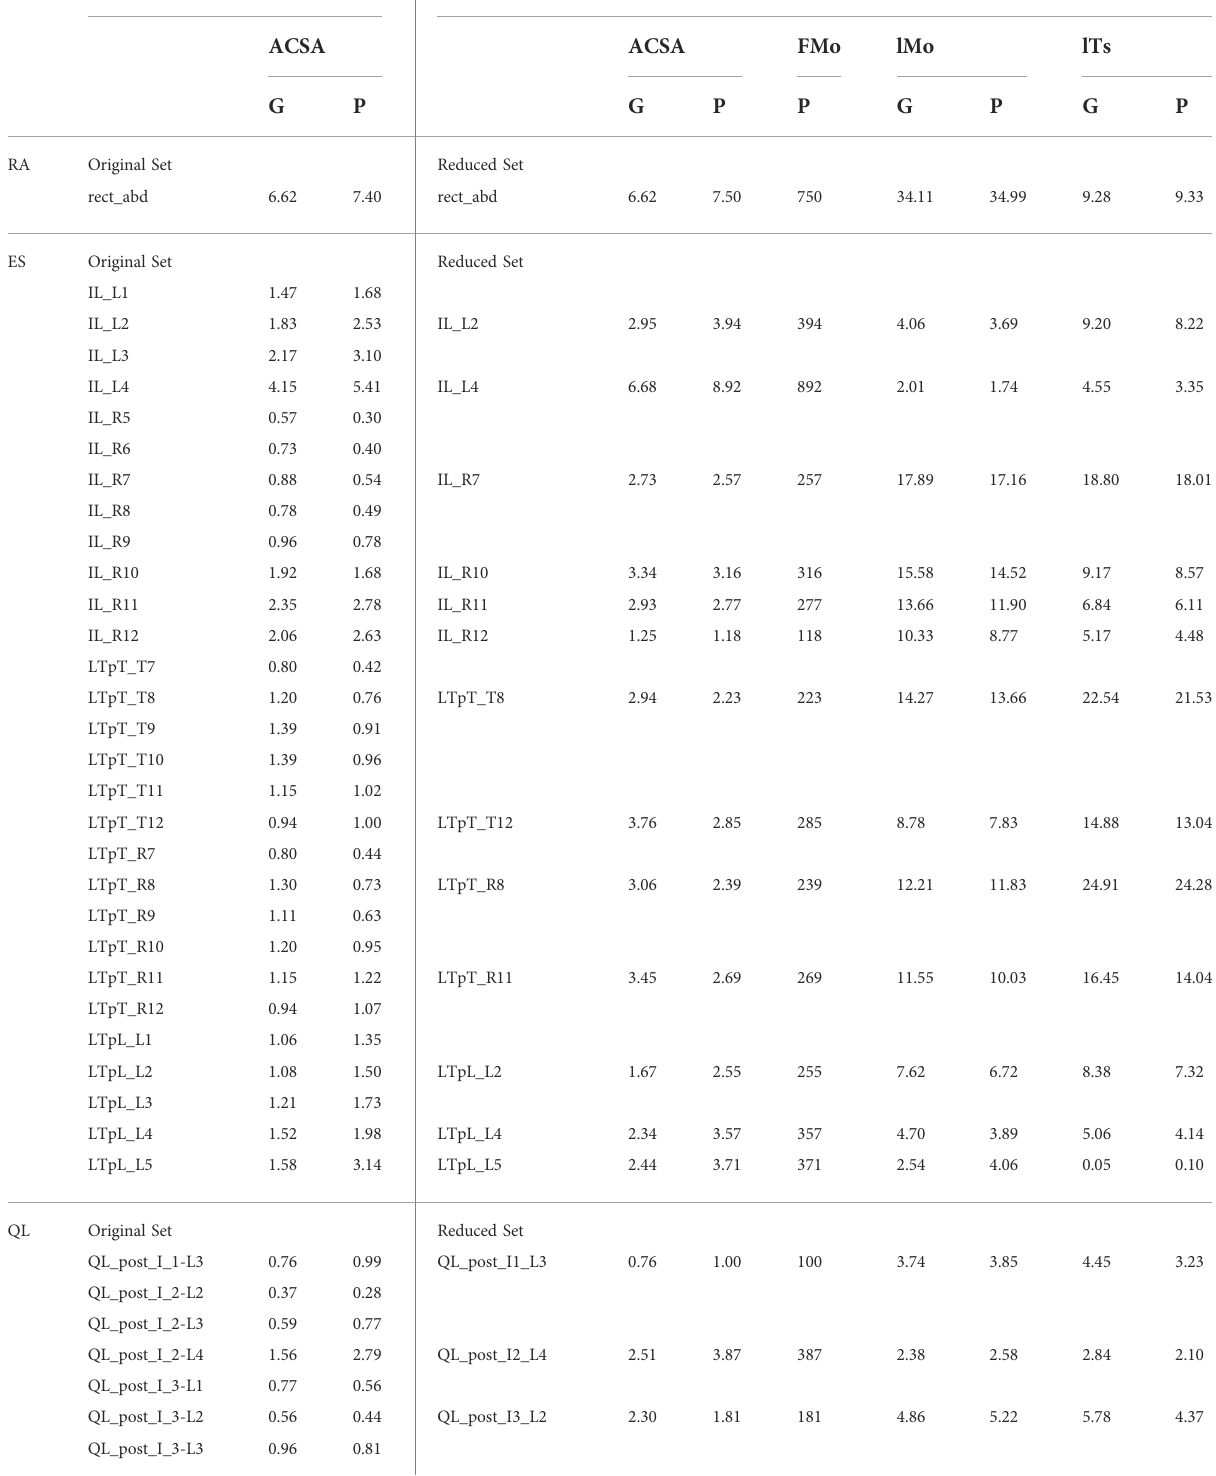
TABLE 2Originalsetoftrunkmusclesincludedin thepublishedOpenSimlumbar spine model (Bruno etal.,2015)andthe reducedsetincluded inthe modi fi ed OpenSim full-body model. ACSA is anatomical cross-section area in cm 2 , FMo is peak isometric force in N, lMo is optimal muscle fi ber lengthincm,andlTsistendonslacklengthincm.Gindicatesalinearlyscaledgenericvalue,andPindicatesapersonalizedvalue.Muscleslistedinthe fi rstcolumnarerectusabdominis(RA),erectorspinae(ES),quadratuslumborum(QL),multi fi